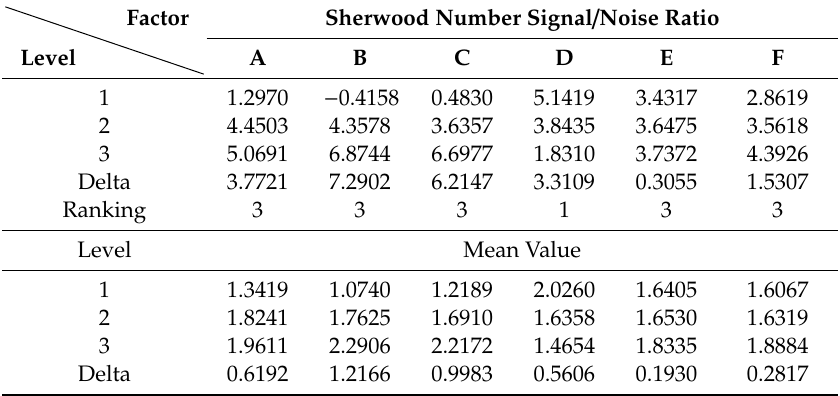
Table 6. The results of the local Sherwood number and signal / noise ratio orthogonal table simulation.